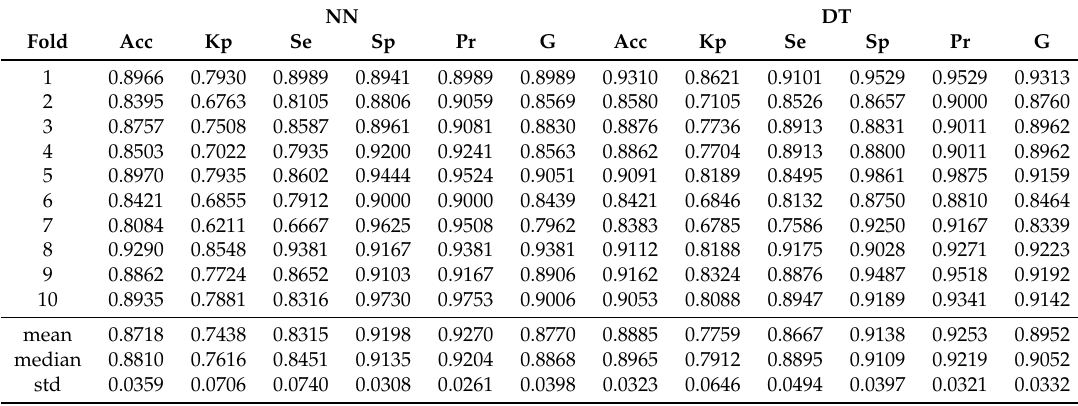
Table 8. Results obtained from the 5 × 2 cv when the threshold is set to 2.5 × g : the different statistics are the Accuracy (Acc), Kappa factor (Kp), Sensitivity (Se), Specificity (Sp), Precision (Pr) and the geometric mean (G), all of them computed using Equations (1) to (8). The models are feed forward NN, Support Vector Machine (SVM), decision trees learned with C5.0 (DT) and Rule-Based systems learned with C5.0